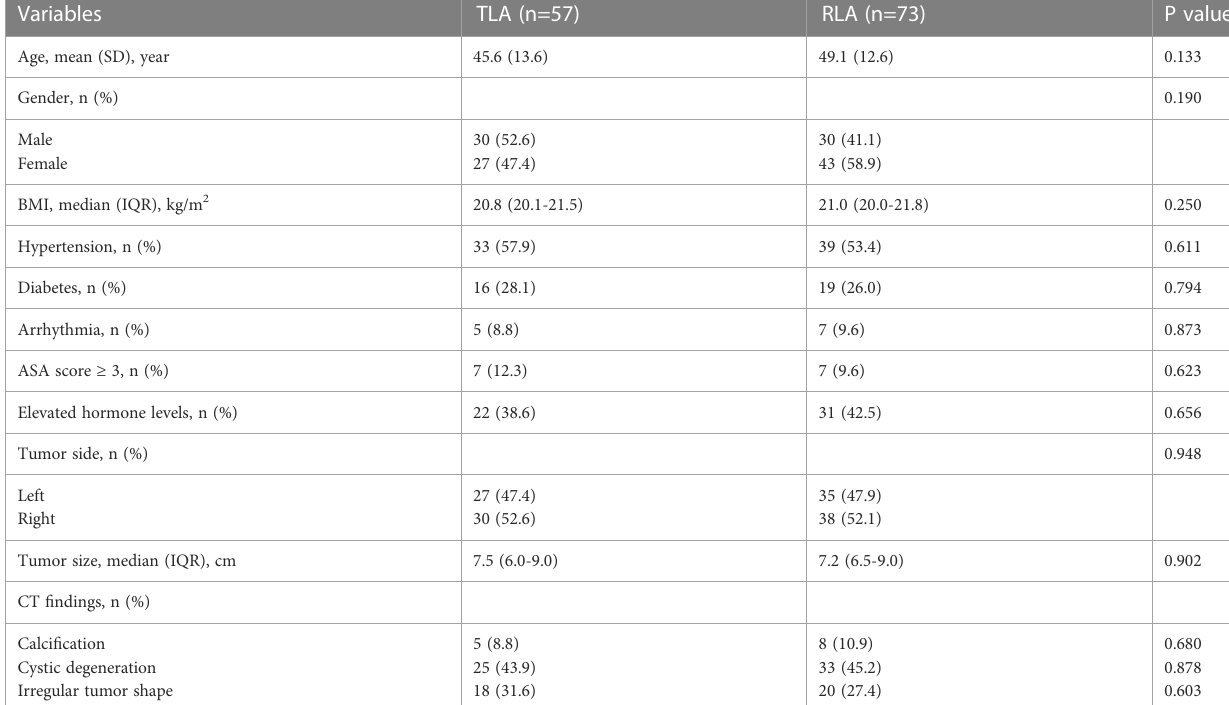
TABLE 1 Preoperative characteristics of patients.